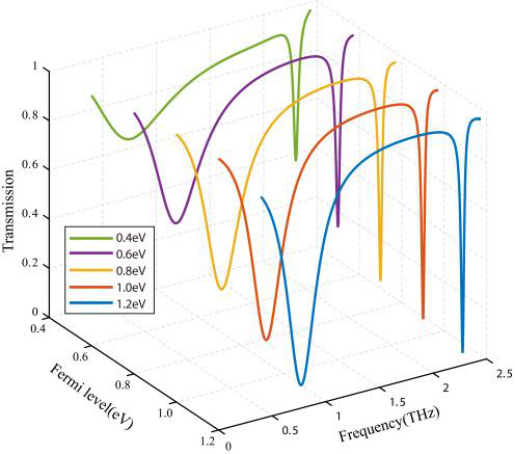
ff erent Fermi levels of